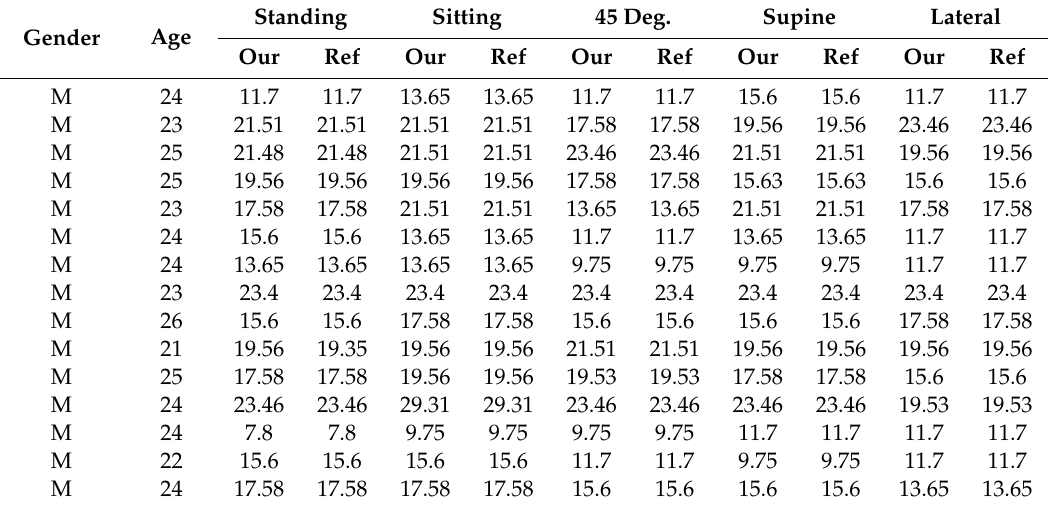
Table A1. Average RR (breaths per minute, BPM) measured by the IJP and e-Health sensors at five di ff erent body